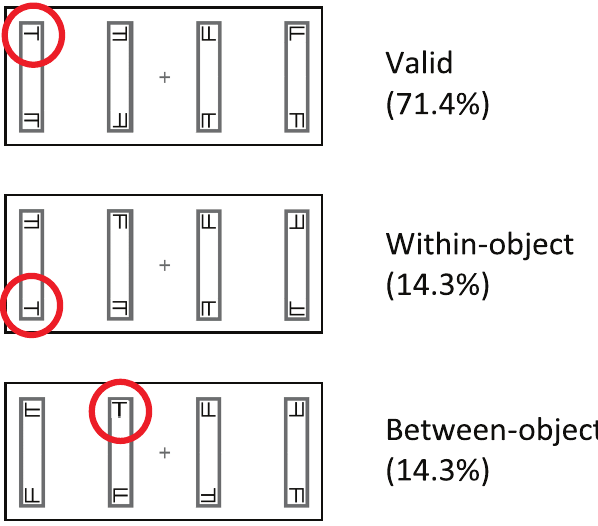
Figure 3. Possible target locations. The three possible target locations are shown relative to the cue location given in Figure